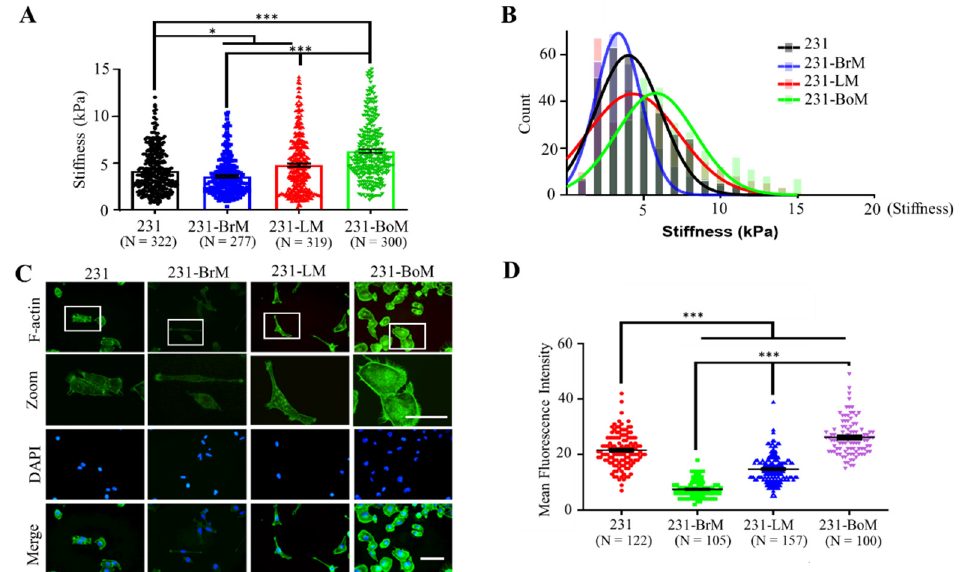
Figure 1. MDA-MB-231 (231) derivatives with the metastatic preference to brain (231-BrM), lung (231-LM), and bone (231-BoM) exhibit increasing F-actin and cellular stiffness. ( A ) Cellular stiffness of 231-BrM cells is lower than that of 231-LM cells that are softer than 231-BoM cells. Tumor cell stiffness was measured by atomic force microscopy. Three independent experiments. ( B ) The histogram of tumor cell stiffness in ( A ). The Young’s modulus distribution was fitted with Gaussian functions (lines). ( C ) The fluorescence imaging of F-actin in 231 derivatives with different metastatic preference. Tumor cells were stained with phalloidin (green) and DAPI (blue). The outlined regions in the top panel were enlarged in the second panel. The representative images were presented. ( D ) Quantification of the fluorescence intensity of F-actin in ( C ). Scale bar: 100 µ m. Three independent experiments. The data represent mean ± SEM. * p < 0.05; and *** p <